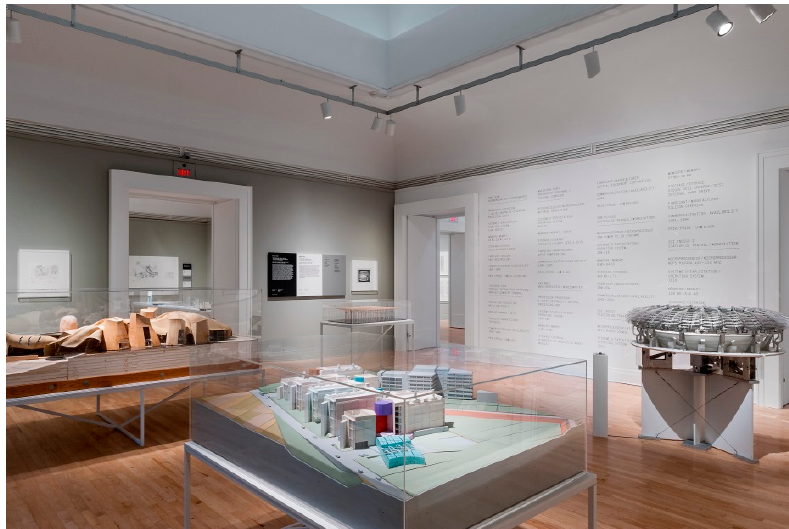
Figure 2. Archaeology of the Digital, installation view with a model of the Biozentrum in Frankfurt by Peter Eisenman in the front, on the left a model of The Lewis House by Frank Gehry and on the right a model of the Dome by Chuck Hoberman, Canadian Centre for Architecture, 2013. Photograph: ©CCA.